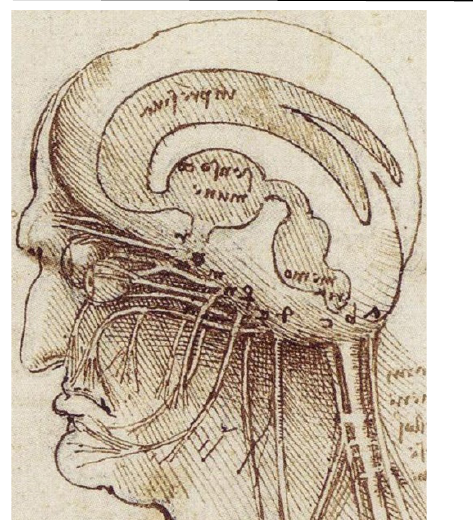
Fig. 2. “Study of brain physiology” (ca. 1508). Drawing in pen and ink by Leonardo after his study of ox brain injections. This rendering of the human brain, ventricles, visual pathways, and skull base reveals Leonardo’s dissection experience and his break from traditional scholasticism, at least as far as personal experience and depiction are concerned [13,14] (Image courtesy of History of Science Collections, University of Oklahoma Libraries).